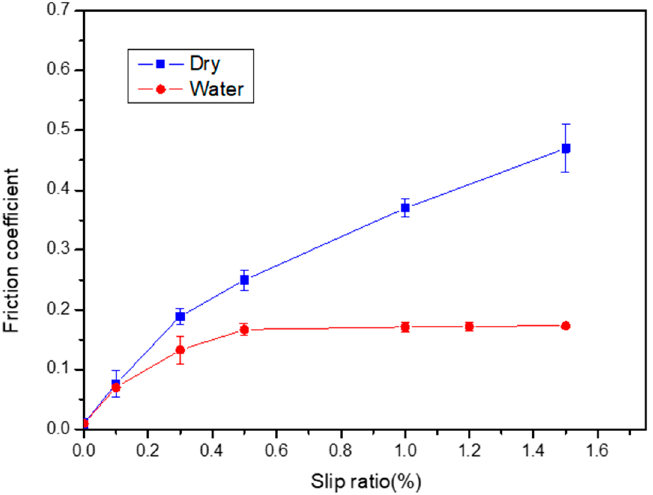
Figure 26. Friction coefficient variation according to slip ratio.